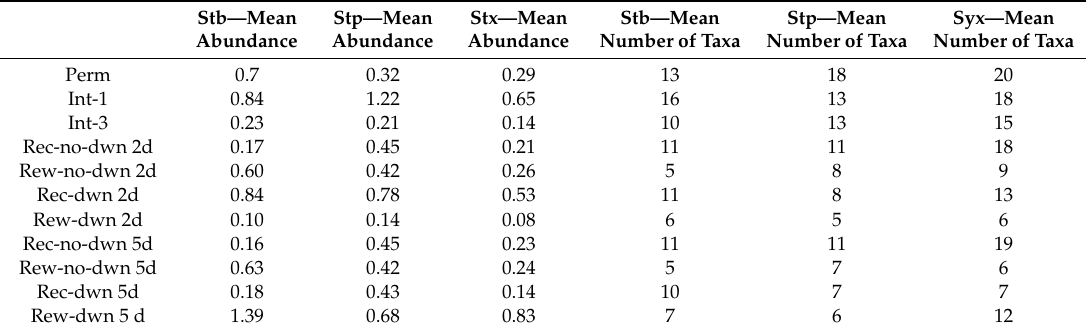
Community metrics for each factor, divided into the three faunistic groups. Stx = stygoxenes; stp = stygophiles; stb = stygobites; Aquifer phase: rec-no-dwn = recession